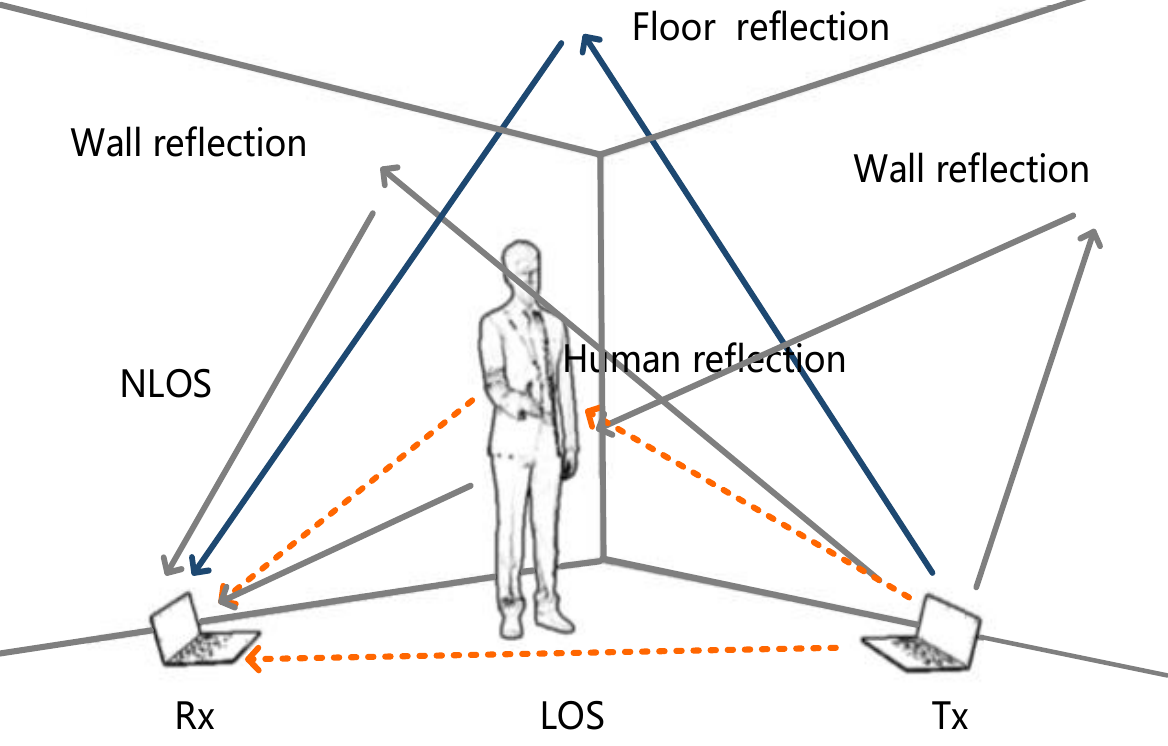
Figure 1. The effect of the human body on Wi-Fi signals.